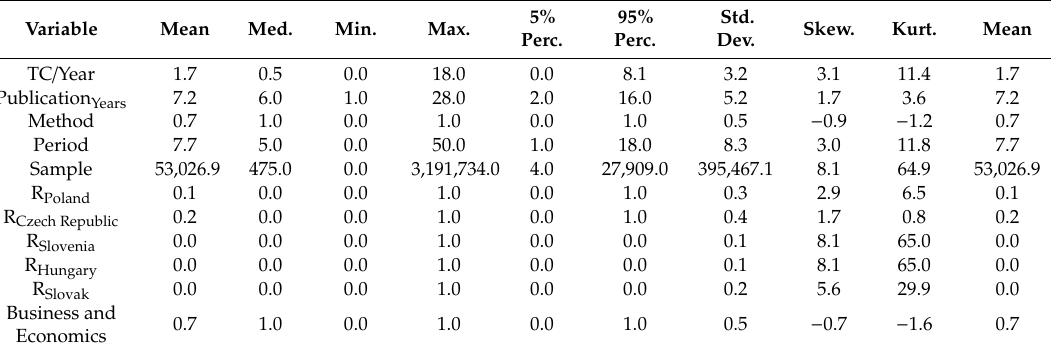
Table 4. Descriptive statistics of the population.